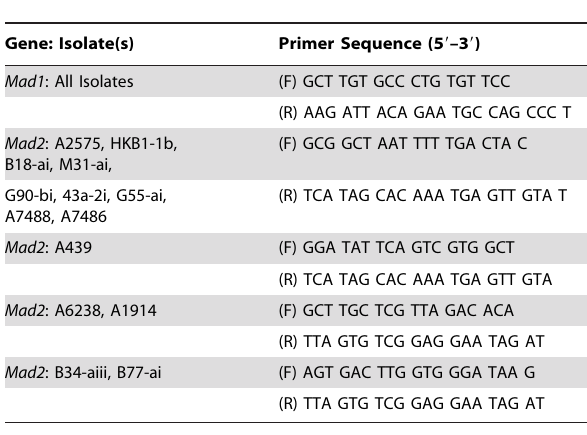
Table 2. Primers used to amplify all Mad1 and